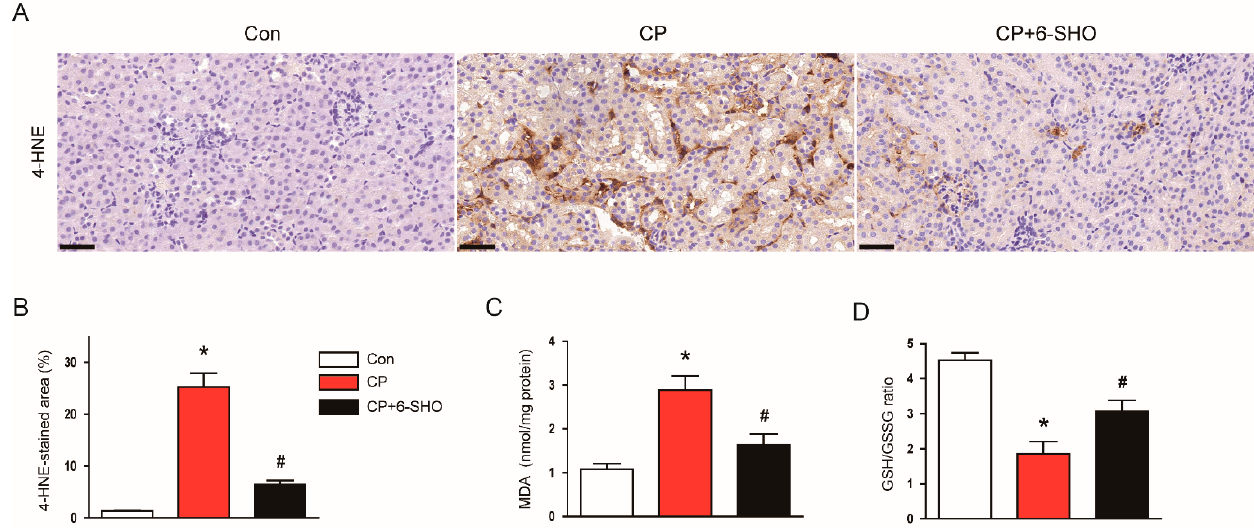
Figure 4. Effect of 6-shogaol on oxidative stress in cisplatin-treated mice. ( A ) Representative images of IHC staining for 4-hydroxynonenal (4-HNE). Scale bar = 40 μ m. ( B ) Quantification of positive staining for 4-HNE. ( C ) Renal levels of malondialdehyde (MDA). ( D ) Ratio of reduced glutathione (GSH) to oxidized glutathione (GSSG). n = 8 per group of mice. * p < 0.05 versus Con. # p < 0.05 versus CP.